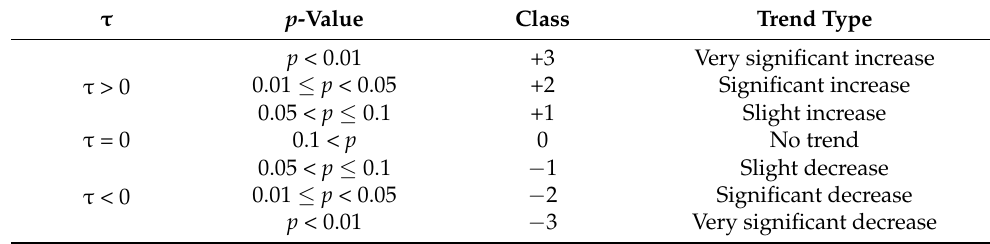
Table 1. Classification of trend in terms of p -value and τ with Mann-Kendall (MK) trend